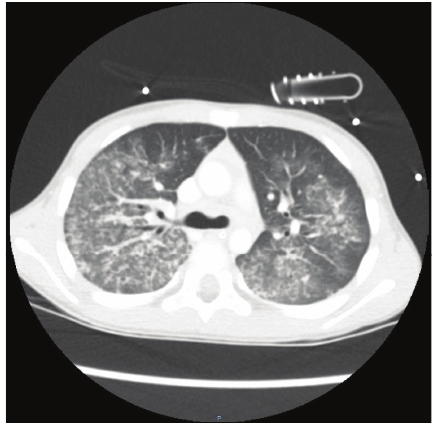
Figure 2: Chest computed tomography shows areas of ground-glass attenuation and a reticular micronodular appearance in both lung fields.